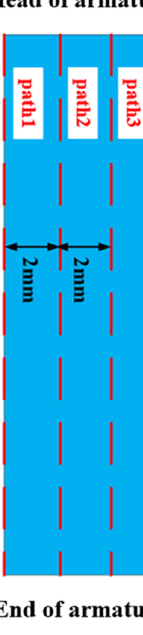
Figure 8: Map of the location of three paths of the armature.